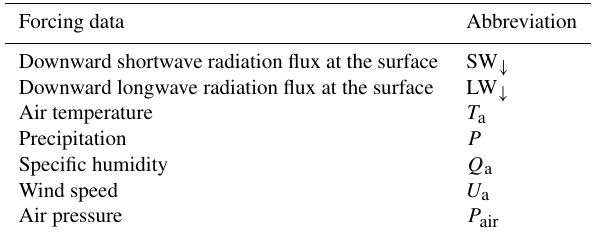
Table 1. Required forcing data for the snow